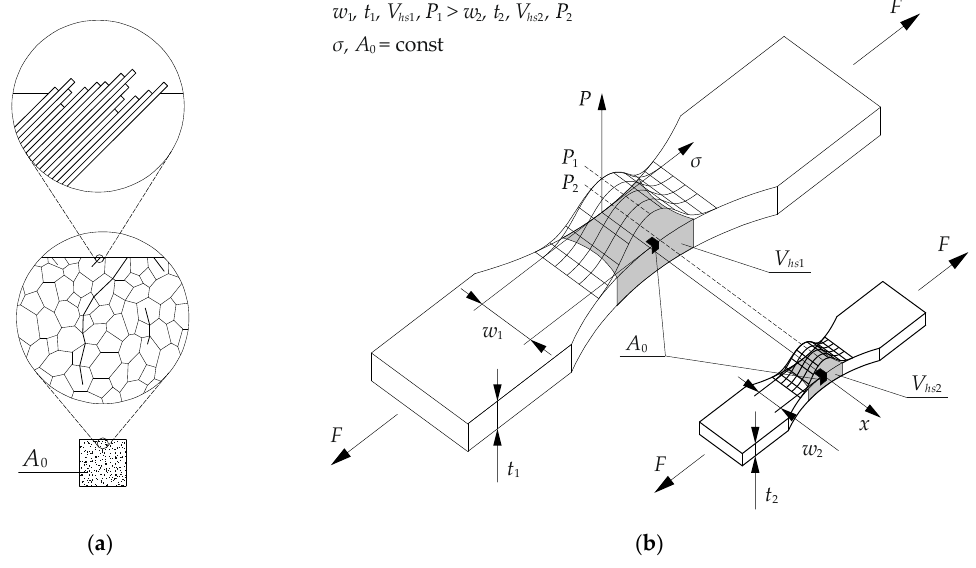
Figure 1. Statistical size effect: ( a ) mechanism of fatigue crack initiation; ( b ) probability of crack initiation. Figure1. Statisticalsizee ff ect: ( a )mechanismoffatiguecrackinitiation; ( b